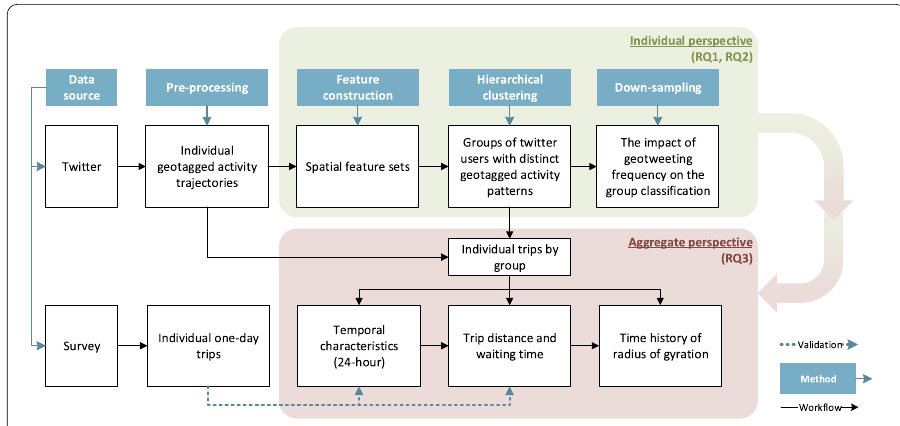
Figure 1 Methods structure. RQ1—Are there any distinct patterns that characterise the observed individual geotagged activities? RQ2—What are the spatial and temporal characteristics derived from